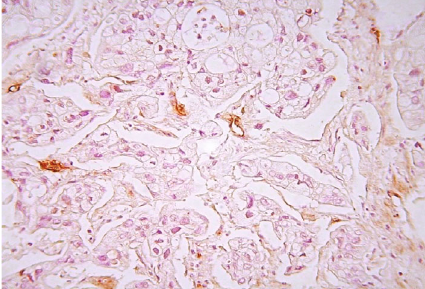
Figure 8: Pancreatic ductal adenocarcinoma, hypovascular area, immunohistochemical staining, Factor VIII, × 200.